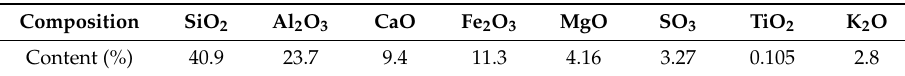
Table 6. Mix Proportion of Self-compacting Concrete (SCC ) (kg/m 3 ). Table 5. Chemical composition of fly ash.